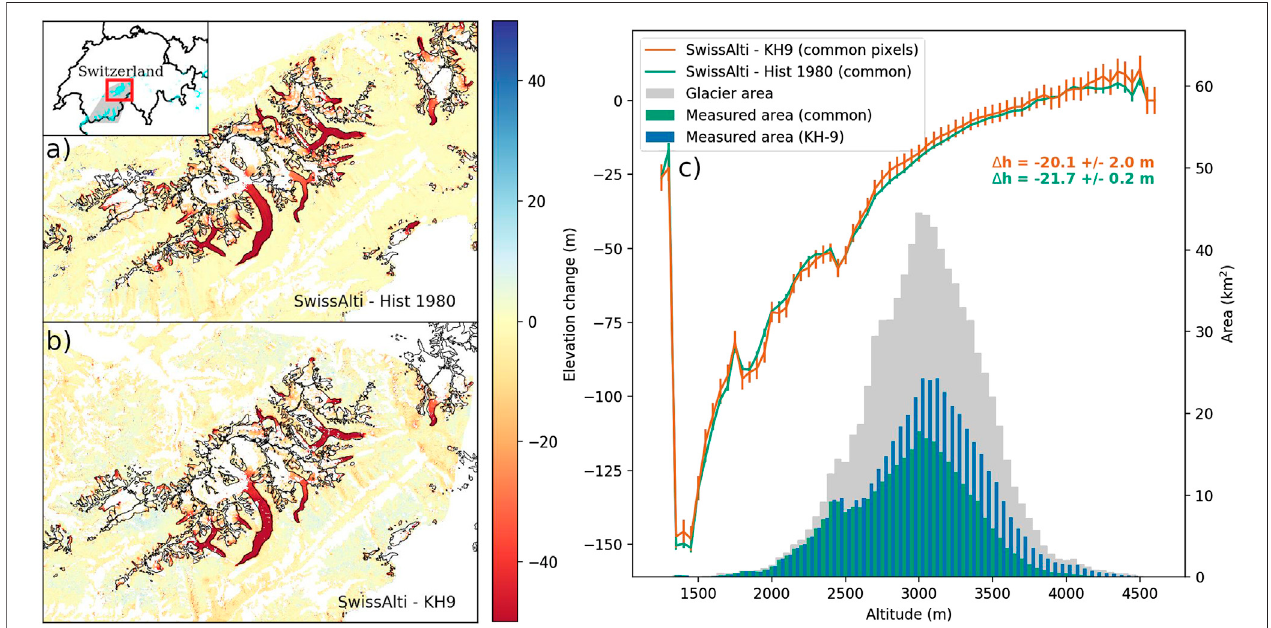
FIGURE 10 | Detail of elevation change maps on a subset of Swiss glaciers obtained by comparing the 2018 DEM SwissAlti3D with (A) the historical 1980 aerial DEM and (B) a 1980 KH-9 MC DEM composite, with black glacier outlines. Inset shows the location map for the whole area analyzed, corresponding to the 1980 aerial DEM extent (gray), zoom extent (red) and glaciers (light blue). (C) Elevation change as a function of altitude from the 1980 aerial DEM (green line) and KH-9 MC DEMs (orange line) with 1 − σ error bars for each 50 m bin. The histograms show the hypsometric distribution of glacier area (gray), area common to both historical DEMs (green) and area from KH-9 MC DEM alone